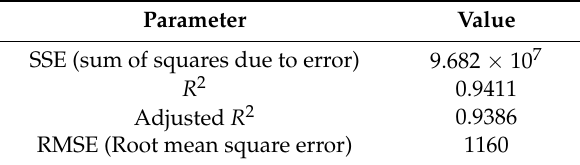
Table 2. The fitting evaluation parameters for the maximum Chl-a concentration.